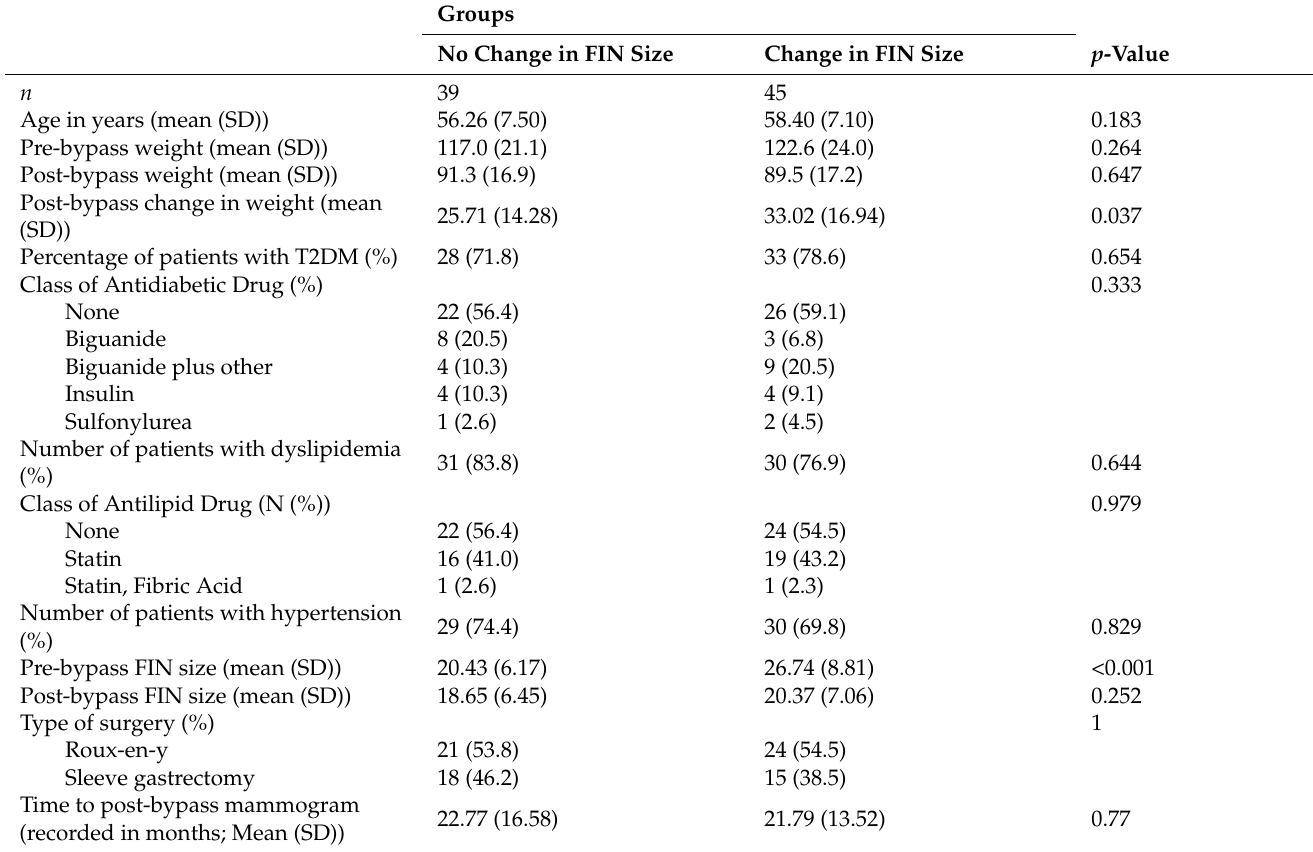
Table 1. Study population characteristics between patients with no change and a change in the fat-infiltrated lymph node size. p -values for continuous and categorical variables were calculated by a two-tailed t-test and a two-tailed Fisher’s exact test, respectively. Weight is expressed in kilograms. Category “biguanide plus other” includes combination therapy with dipeptidyl peptidase-4 inhibitor, GLP-1 agonist, insulin, or